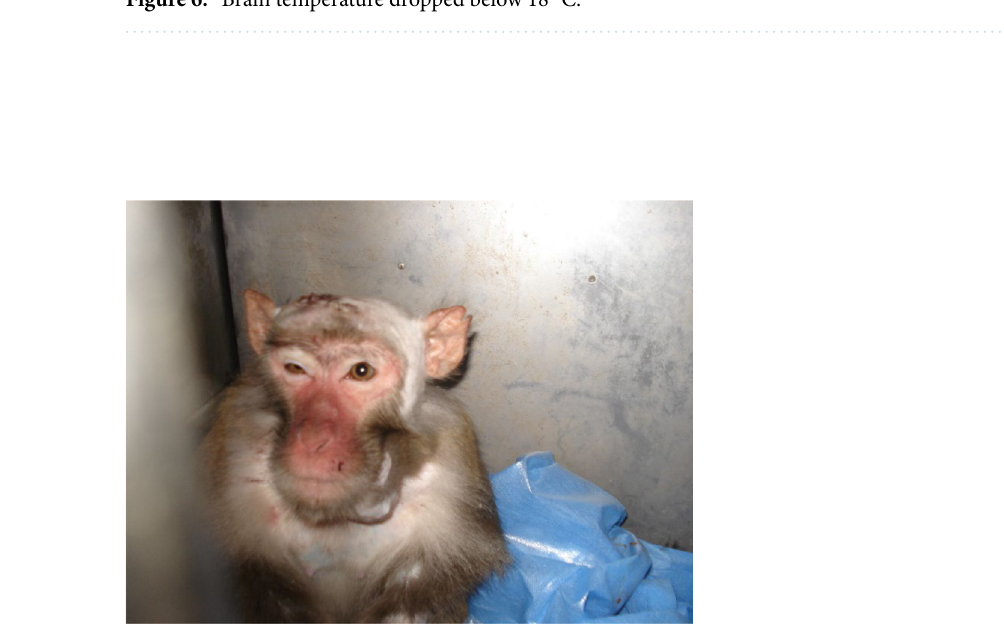
Figure 6. Brain temperature dropped below 18 °C.